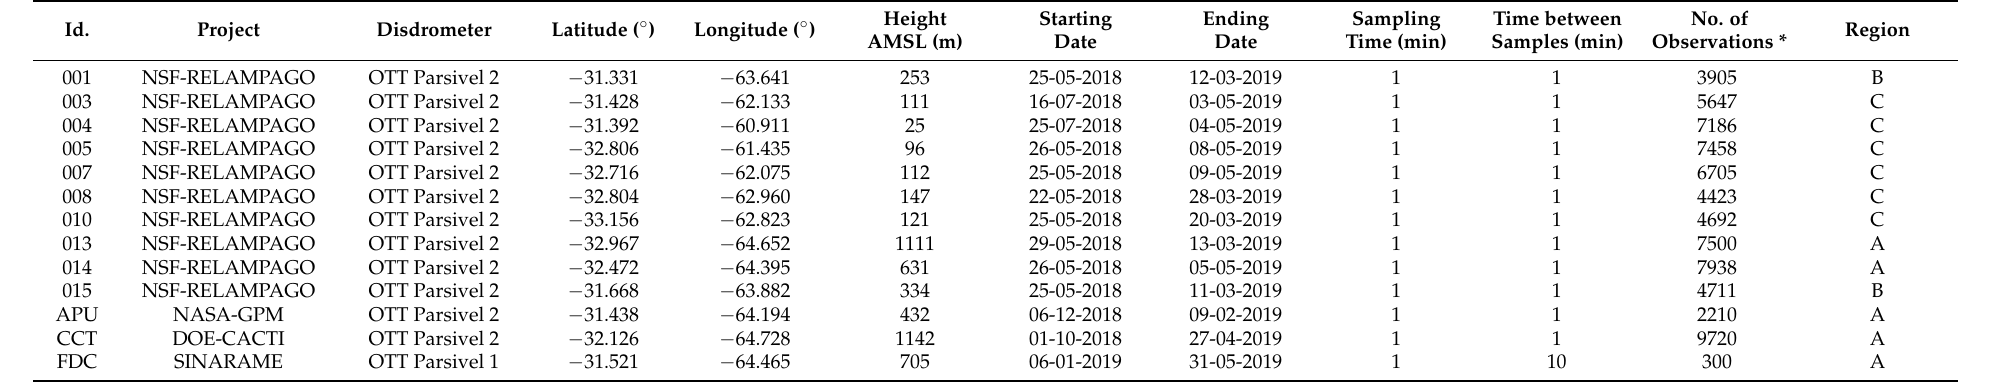
Table 1. Details of each disdrometer dataset including project, type of disdrometer, location, height AMSL, period of observation, sampling time, time between observations, total number of observations and region (* valid 1 min samples that remain after the QC and filters applied to the dataset).